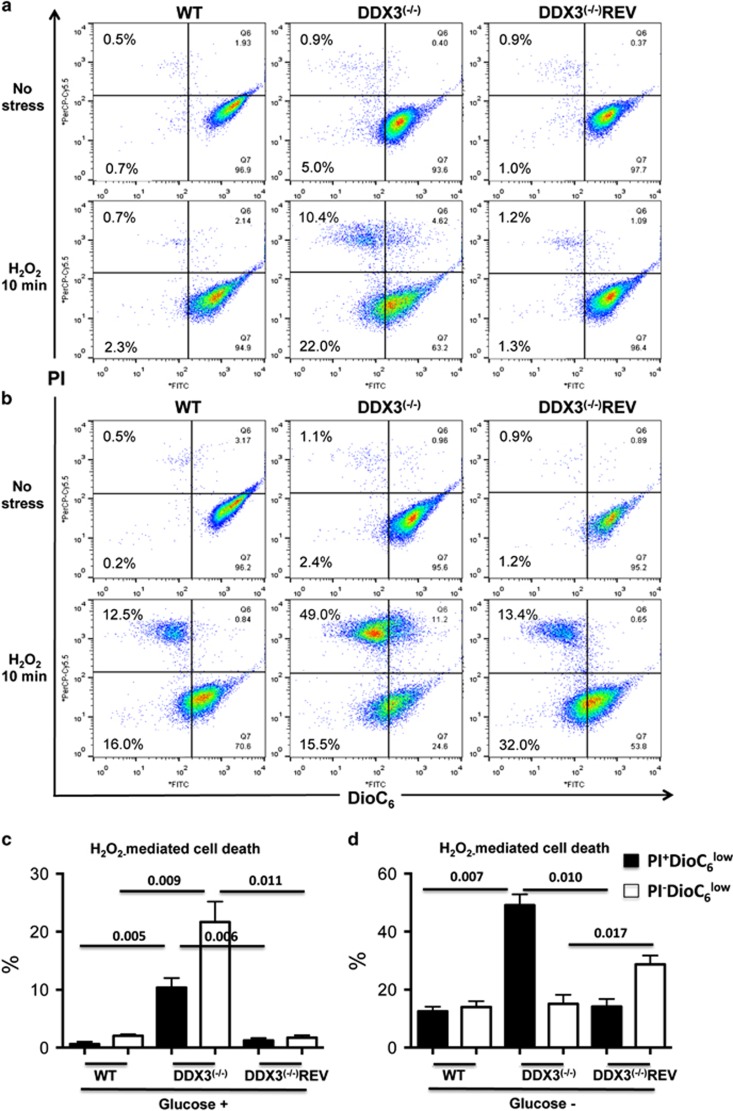
Mitochondrial membrane potential loss and cell death are greatly enhanced upon oxidative stress in DDX3(−/−)
Leishmania forced to use the mitochondrial oxidative respiratory machinery. (a) Flow cytometric analysis of DiOC6(3)- and PI-labeled L. infantum WT, DDX3(−/−), and DDX3(−/−)REV grown in RPMI glucose-rich medium. Parasites were treated or not with 0.6 mM of hydrogen peroxide (H2O2) for 10 min, washed out, and further incubated in a fresh medium for 5 h prior to their analysis by flow cytometry. (b) As in (a) but parasites were cultured in DMEM glucose-free medium. The experiment was repeated three times with duplicates and statistical analysis of these results performed as in Figures 3b. (c) Glucose (+) medium) and (d) glucose (−) medium. The numbers over the lines correspond to P-values